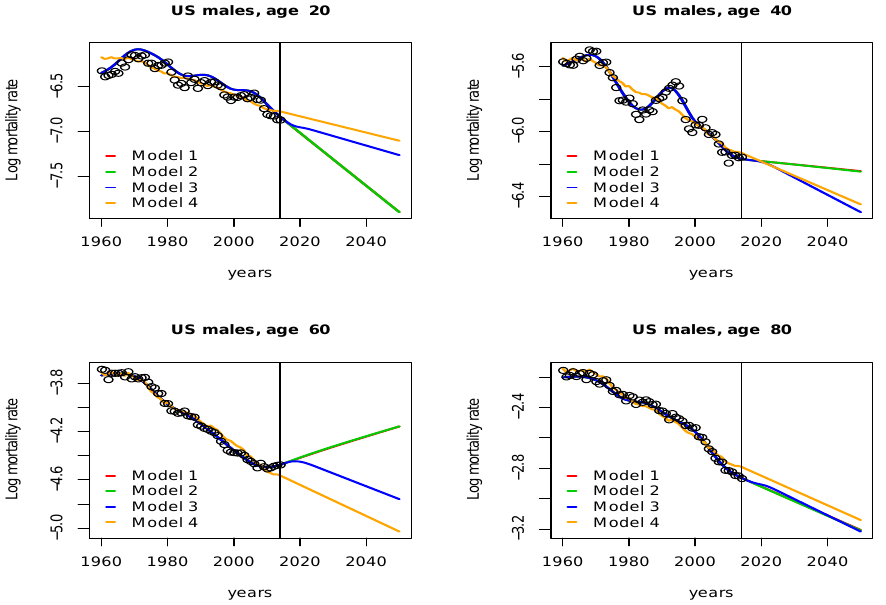
Figure 2. Fit and forecast of selected ages: 20, 40, 60 and 80 obtained using model 1 (red line), model 2 (green line), model 3 (blue line) and model 4 (orange line). The vertical line indicates the year from which we predict